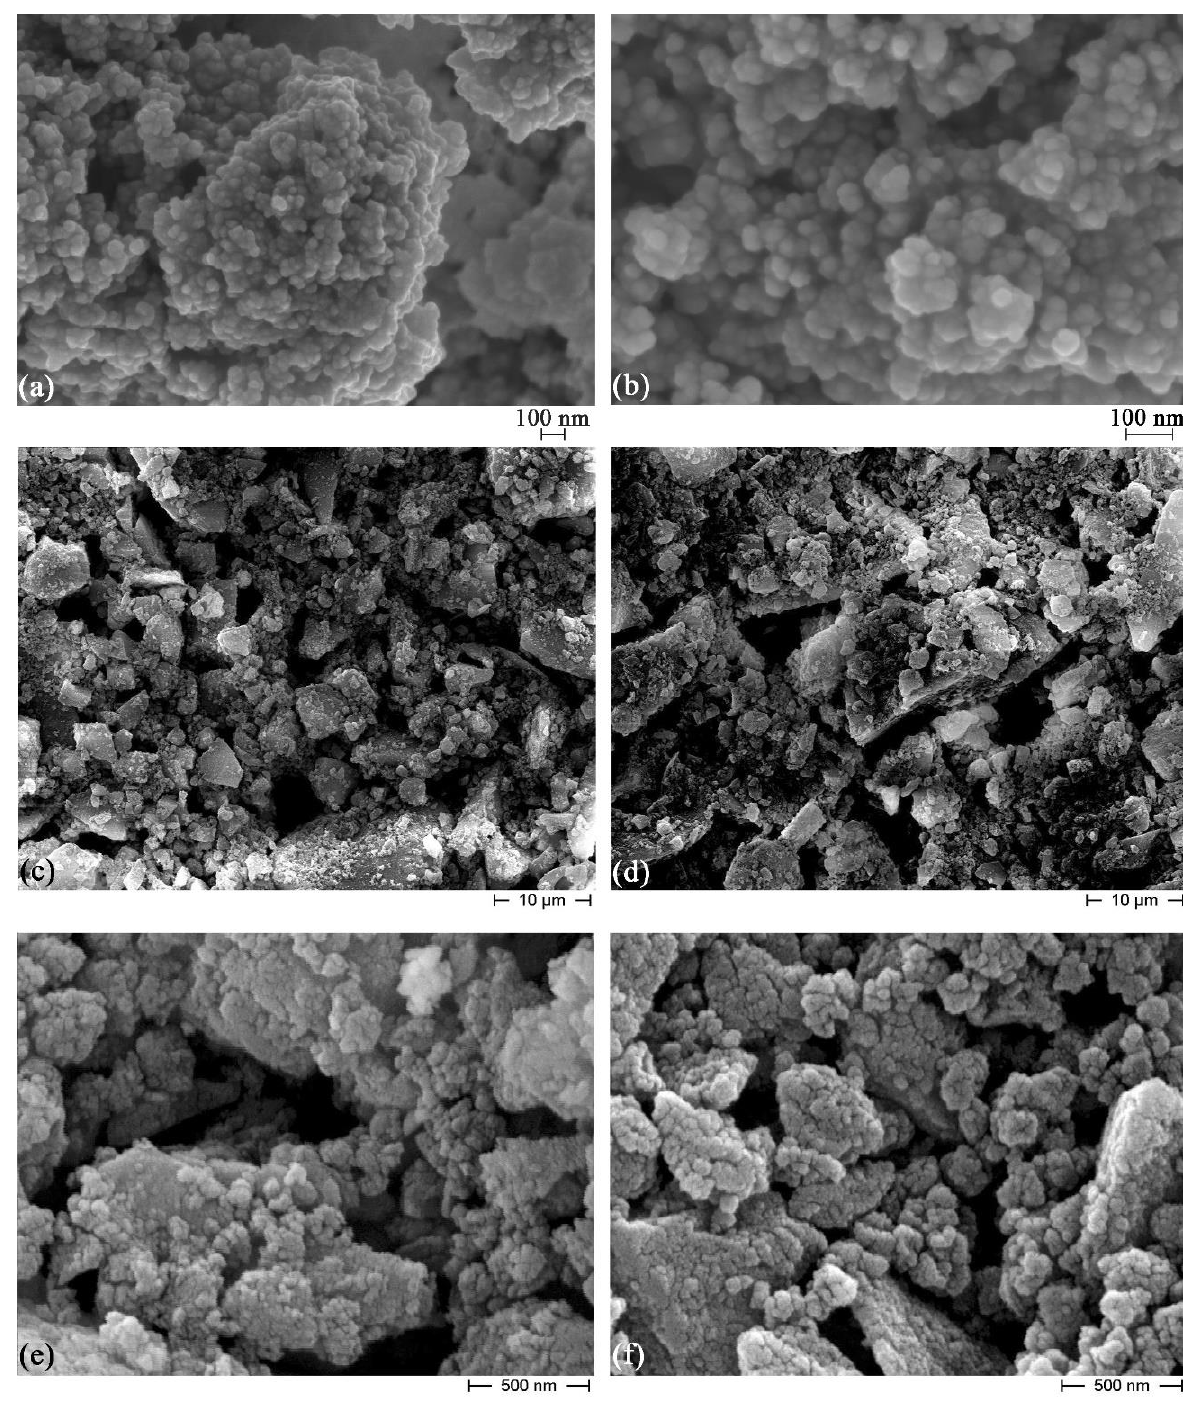
Figure 6. FESEM micrographs of: sol S1FESUB after drying in the oven ( a , b ); screen-printed films S1FeSUB ( c , e ) and S1FeXS ( d , f ), at various magnifications, after calcination at 550 °C for 1 h.